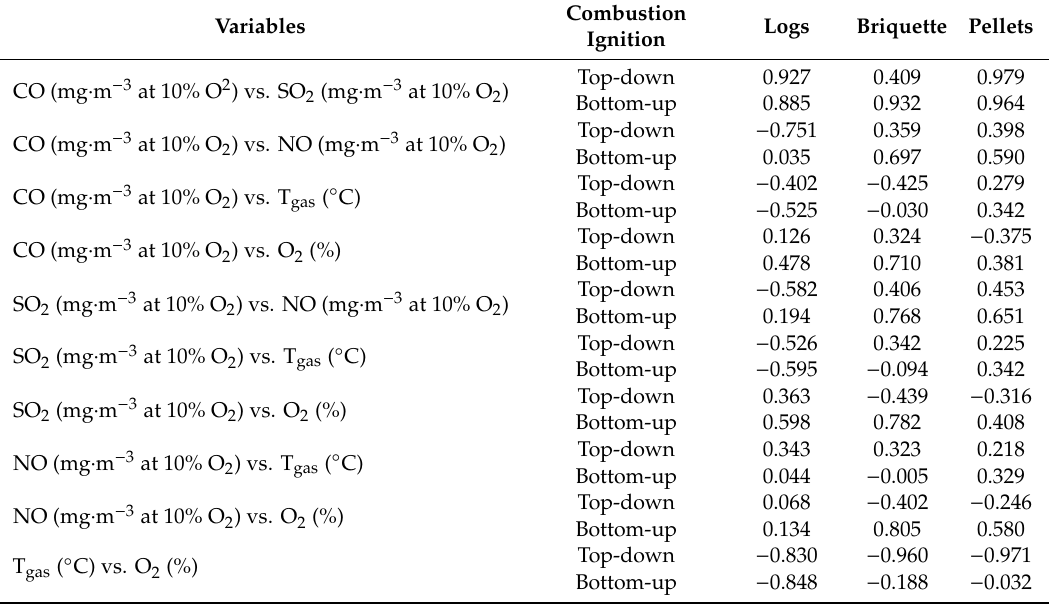
Table 3. Spearman correlation coe ffi cient R for the relationship between the gas combustion products (values recorded in bold are statistically